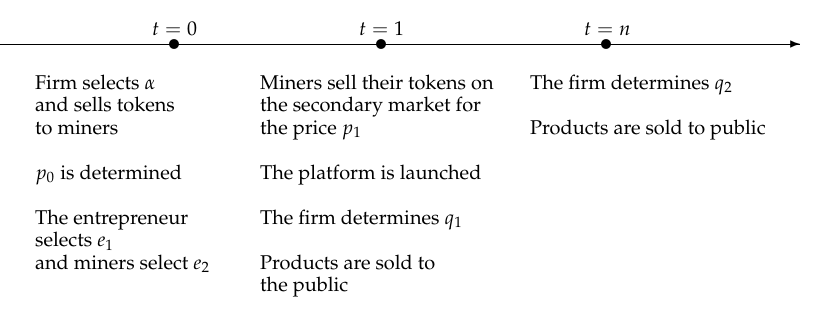
Figure 4. The sequence of events with moral hazard and market uncertainty for security